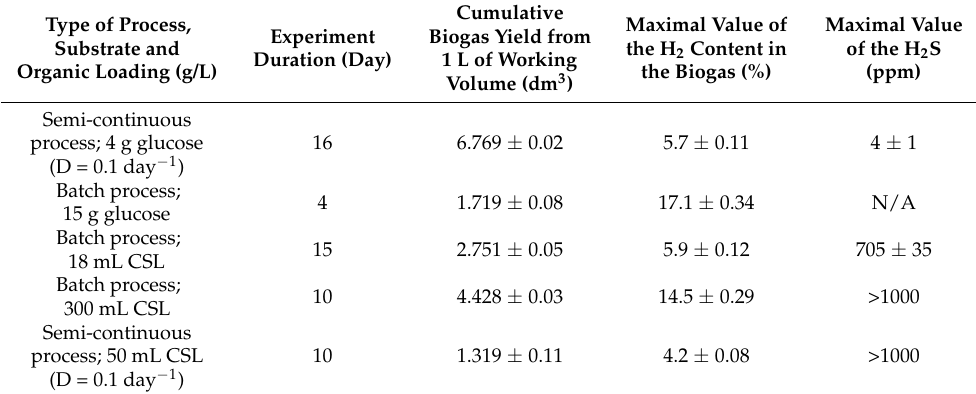
Table 3. Batch and semi-continuous experiments with glucose and CSL.